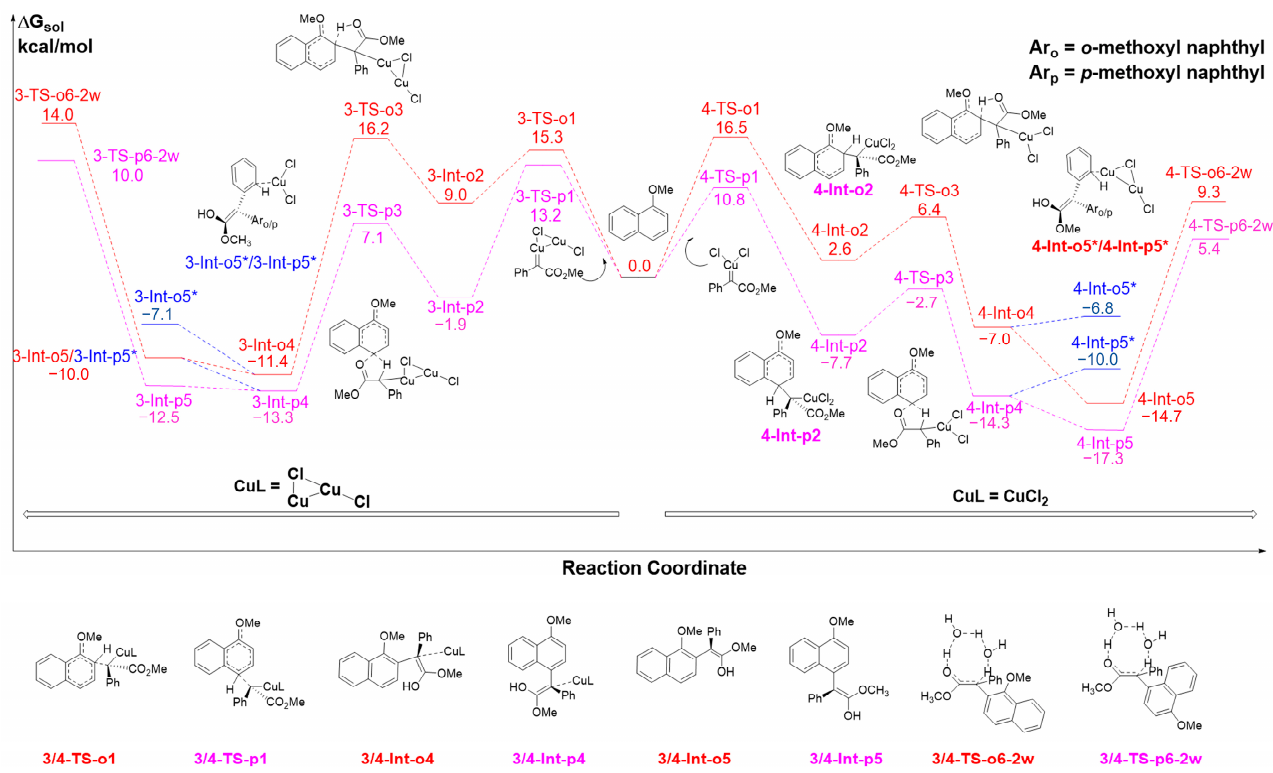
Figure 7. The calculated free energy profiles Δ G sol and the corresponding structures of intermediates and transition states along different pathways of the C–H bonds of 1-methoxynaphthalenes inserted by the bimetallic and monometallic Cu carbenes. The reasonable ortho-selective pathways are shown in red, the para-selective pathways are pink, and other possible pathways are in blue. The free energies are given in kcal mol − 1 . Ar o = o-methoxyl naphthyl, Ar p = p-methoxyl naphthyl.